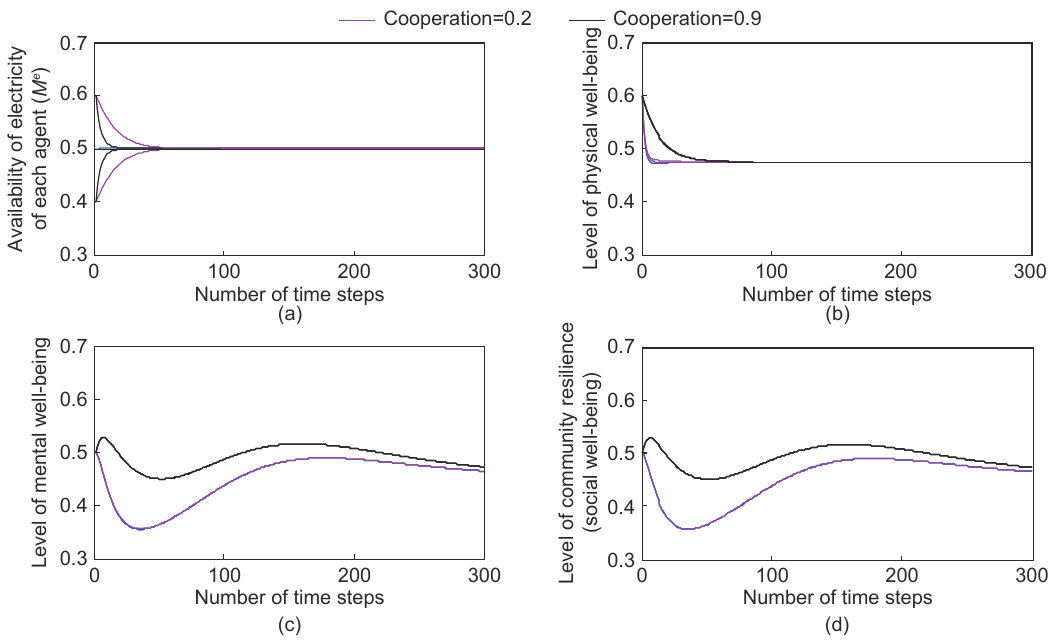
Fig. 6 Effects of different initial values of cooperation on the availability of electricity, physical well-being, mental well-being, and community resilience. Results are provided for different levels of cooperation (0.2 and 0.9). In this homogeneous community, the accessibility of agents to DERs varies. The dynamic change of all kinds of well-being is provided for the time interval [0,